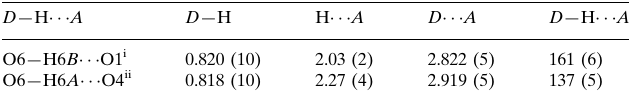
Hydrogen-bond geometry (A˚ , (cid:2)